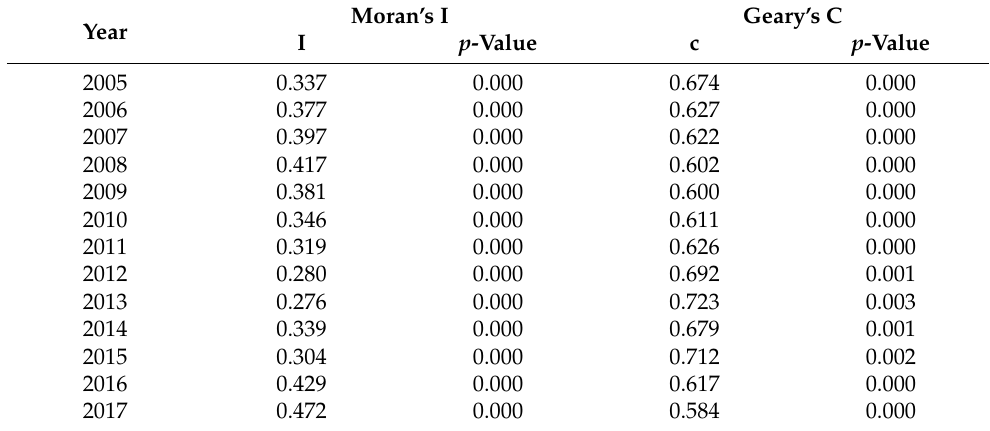
Table A3. Spatial correlation